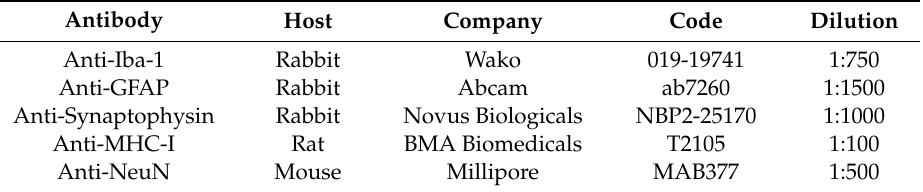
Table 1. Detailed description of the primary antibodies